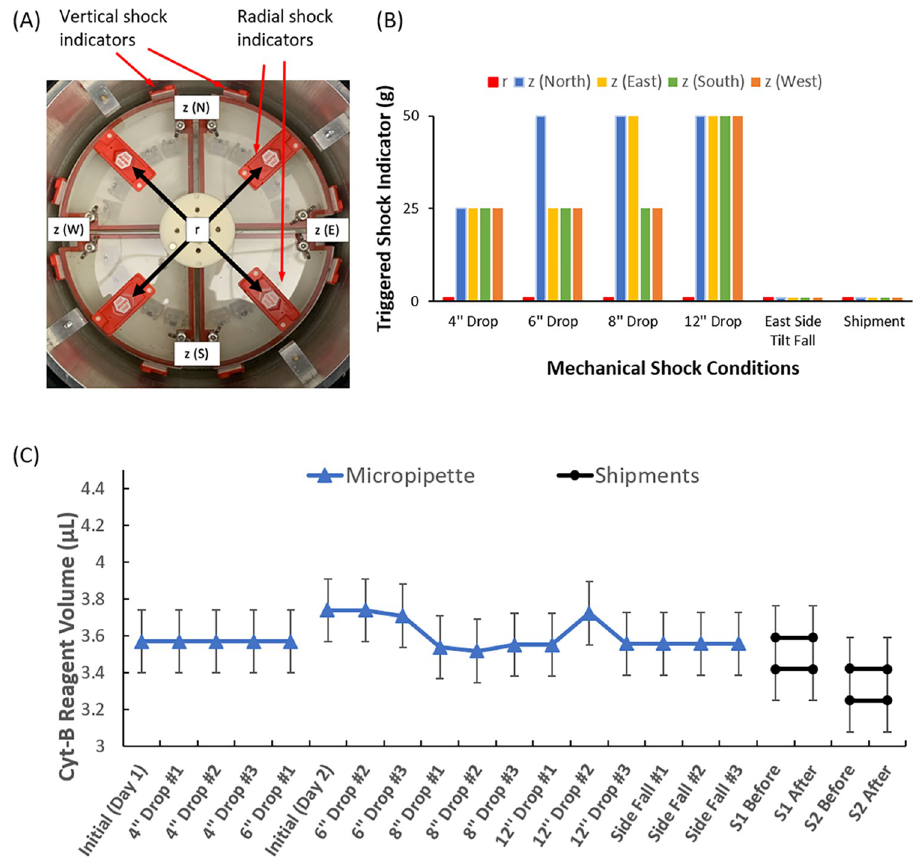
Fig 5. Assessing the ability of the 40 μ m micropipette with fluorocoating against premature reagent release under mechanical shocks. (A) top view of the SDA with mounted 25g and 50g shock indictors at different locations. (B) Maximum g-force of the shock indicator triggered for each condition from three trials. (C) Reagent volumes inside the micropipettes under different conditions demonstrate the resistance to premature reagent release by the micropipette